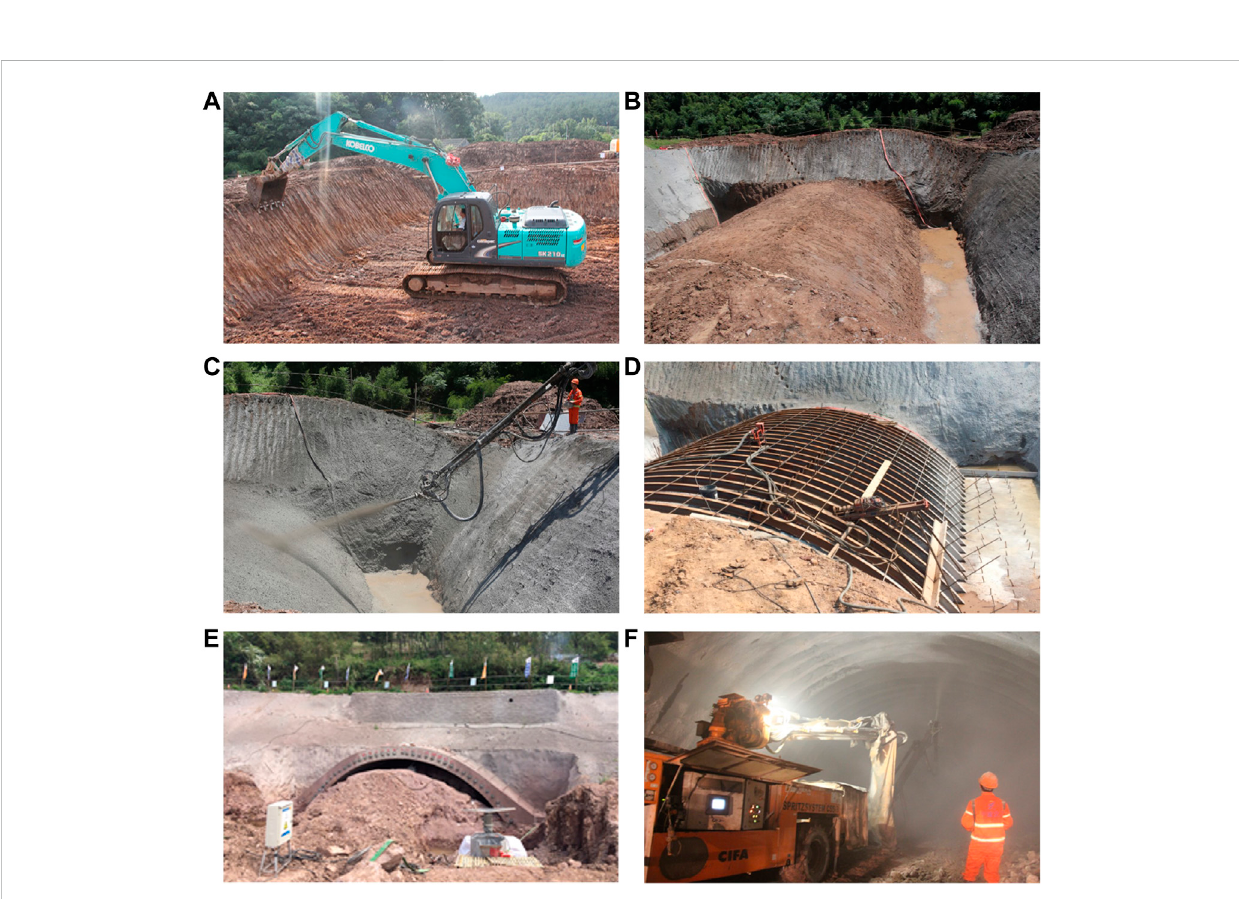
FIGURE 15 Site construction diagram of shallow-buried cover excavation section Ⅰ : (A) Slope excavation and dressing; (B) Schematic diagram of soil mold; (C) Soil arch hardening treatment; (D) I-beam installation and split screw installation; (E) Excavation of underground tunnel; (F) Initial shotcrete